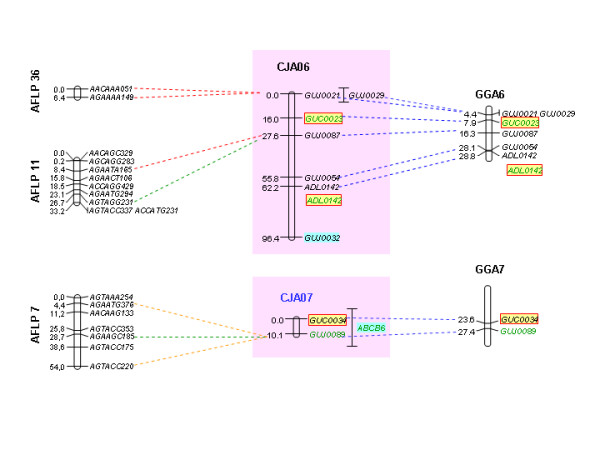
Alignments of Japanese quail microsatellite and AFLP maps and links to the assembled chicken sequence. Left: AFLP linkage groups from [14]; center: integrated microsatellite and gene map (this study); right: chicken February 2004 sequence assembly [22]. AFLP and microsatellite genetic maps are in cM and the sequence assembly is in Mb. New quail linkage groups have blue titles and new microsatellite and gene markers are in green. Genes are in boldface italic. Microsatellite markers informative in both species are in red boxes. Chicken markers have a yellow background. Quail microsatellites or genes with similarity to chicken sequence of unknown location (chrun) have a blue background. Dotted lines linking the microsatellite and the AFLP maps indicate positive results of two-point linkage between the markers, with supporting LOD scores of 3 to 6 (green), 6 to 10 (orange) or more than 10 (red).